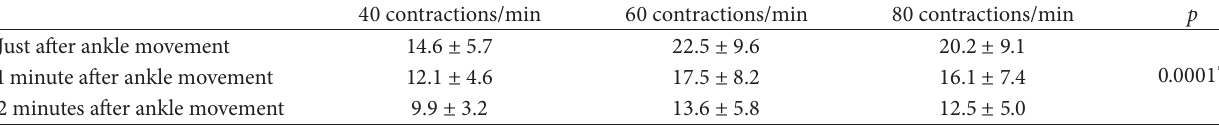
Table 2: Preoperative mean velocity of blood flow of profunda femoris measured one day before surgery.